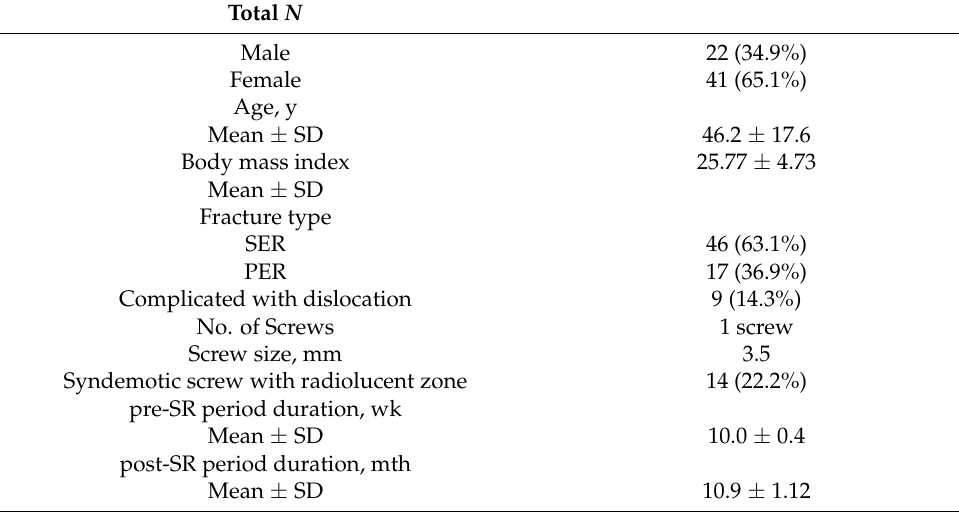
Table 1. Patient